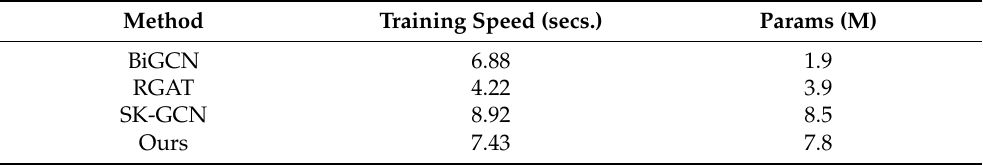
Table 5. Results of run time and the parameter amount of different methods.